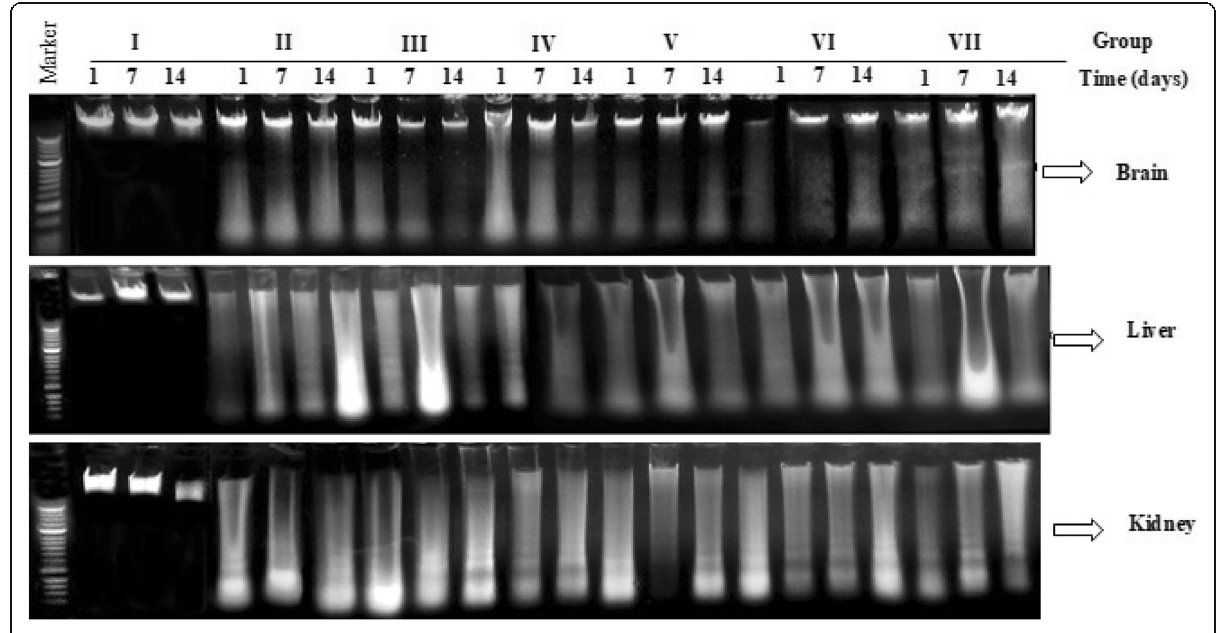
Fig. 1 Gel electrophoresis pattern of the genomic DNA extracted from the brain, liver, and kidney of control rats (I), and those administered 0.5 g and 1.0 g of NiO-NPs (II and III), 0.5 g and 1.0 g of Co 3 O 4 -NPs (IV and V), as well as mixtures of NiO-NPs + Co 3 O 4 -NPs (0.25 g + 0.25 g, VI) and (0.5 g + 0.5 g, VII) per kg body weight,